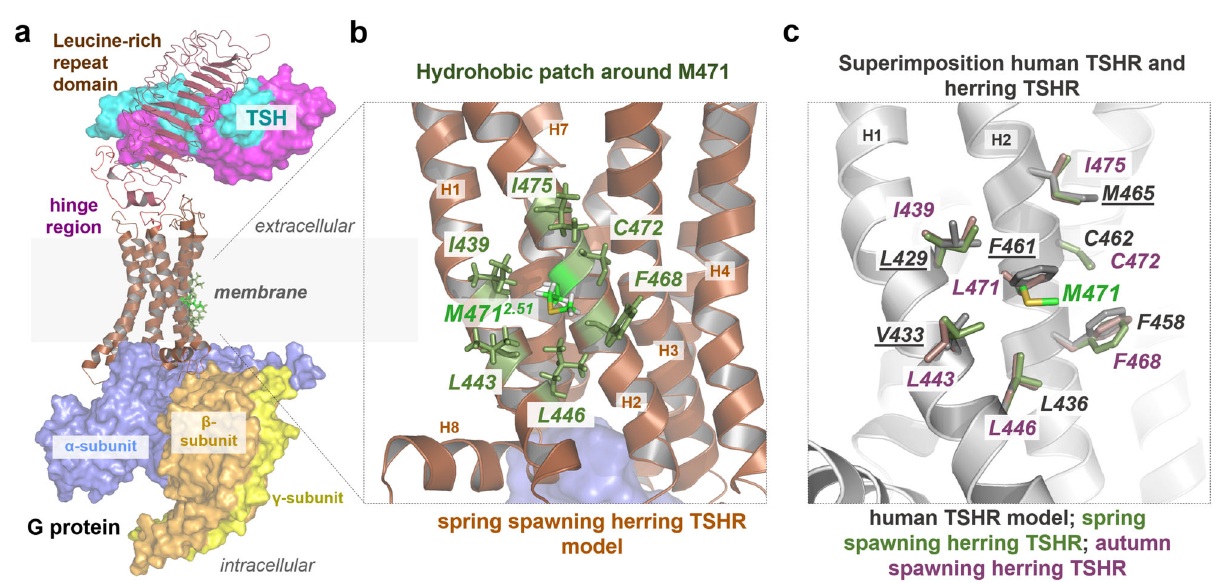
Fig. 6 TSHR complex structural models and comparison of the TMH2 L471M variant. a The entire complex model of herring TSHR with M471 highlighted in green (position 2.51) shows that this residue is outside the ligand or Gs-protein binding site. b Close-up view of M471 2.51 reveals that the side chain is directed towards the membrane and surrounded by a tight hydrophobic patch. c Superimposition of herring and human TSHRs reveals similarities and differences within the hydrophobic patch and also the potential side-chain orientations of leucine (autumn herrTSHR), methionine (spring herrTSHR), and phenylalanine (humTSHR). The human TSHR side chains that differ from those of herring TSHR are